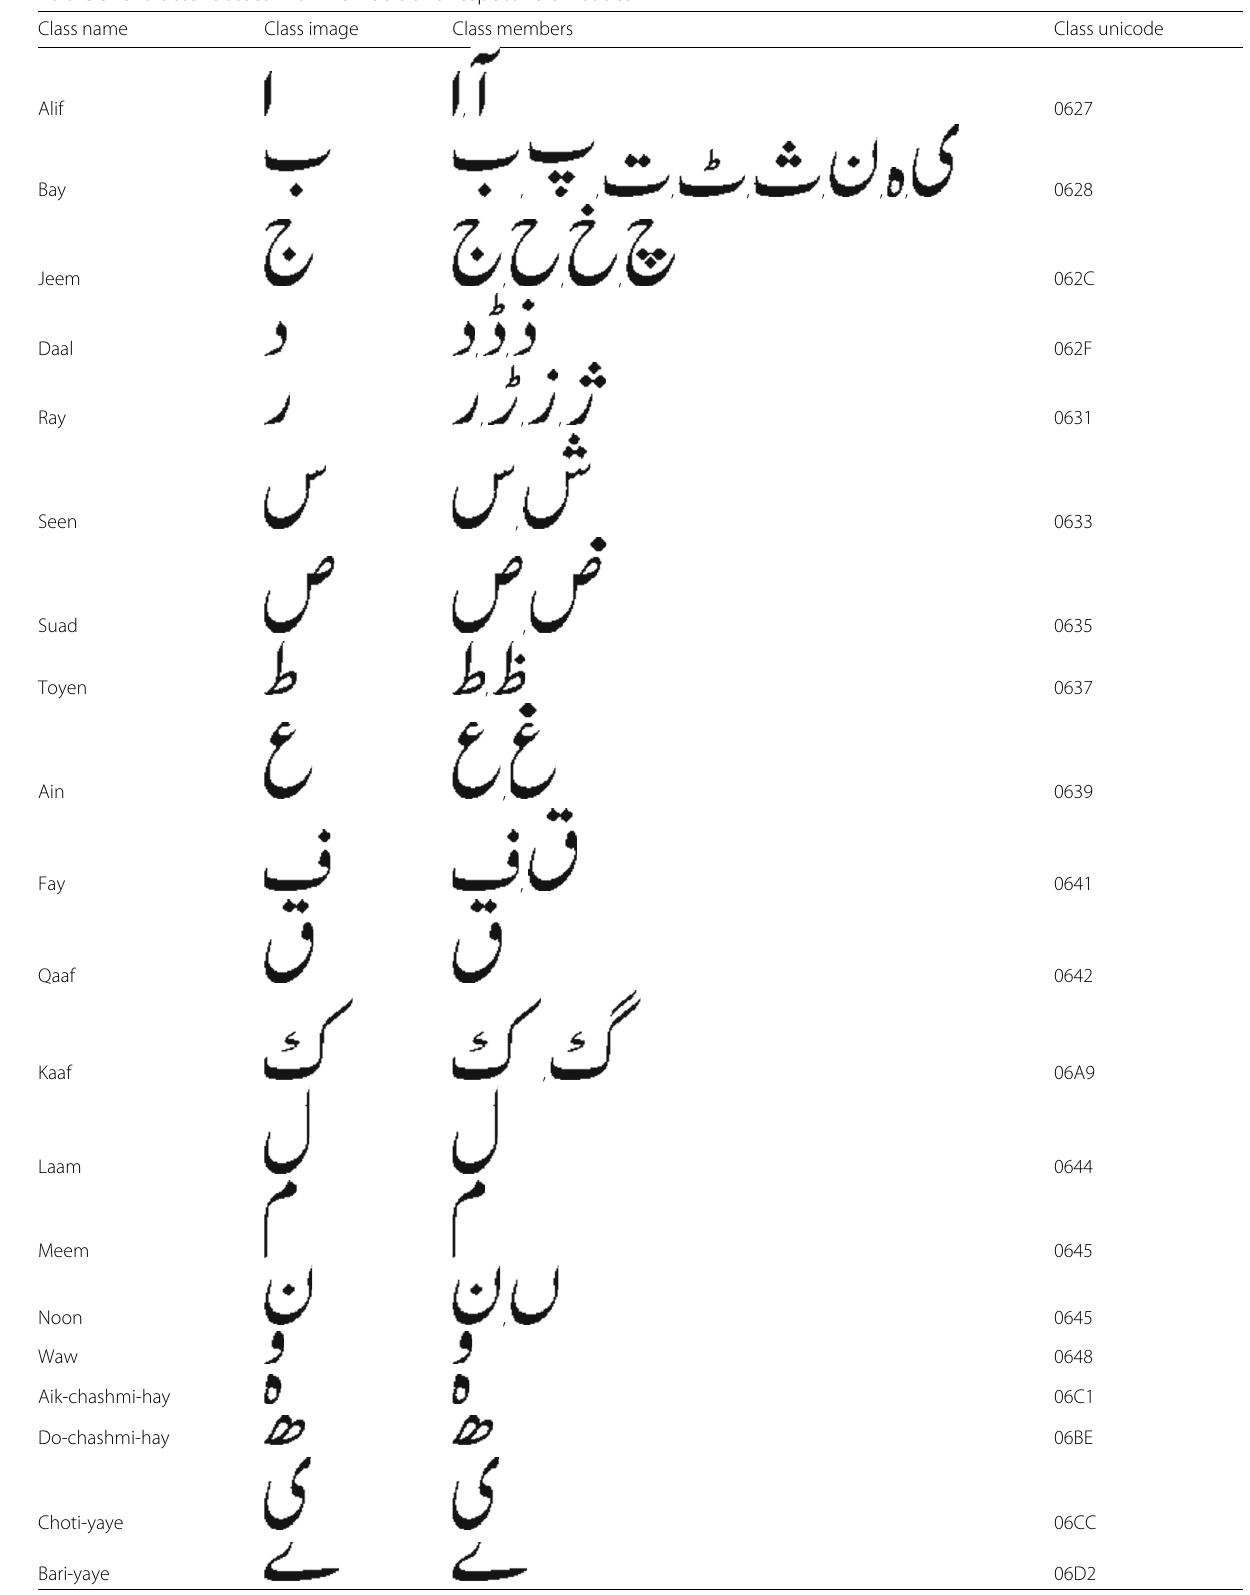
Table 3 Character classes with members and respective